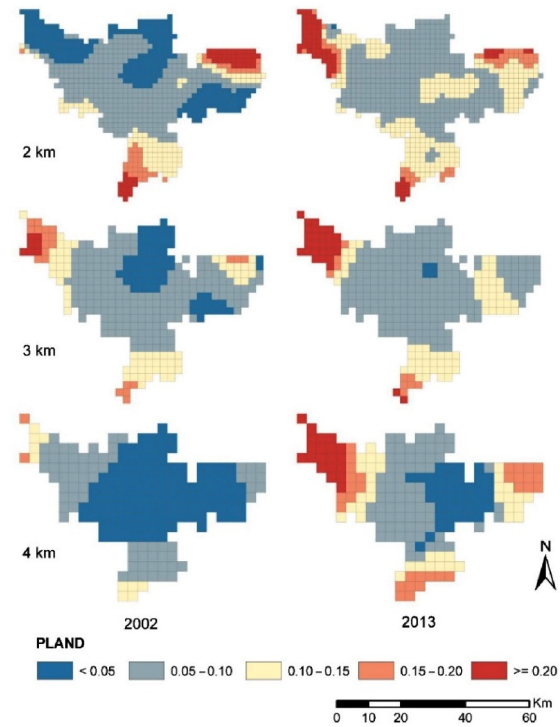
km)Figure 5. Spatial distributions of the correlation coefficients obtained from GWR for PLAND at three scales (2 km, 3 km, and 4